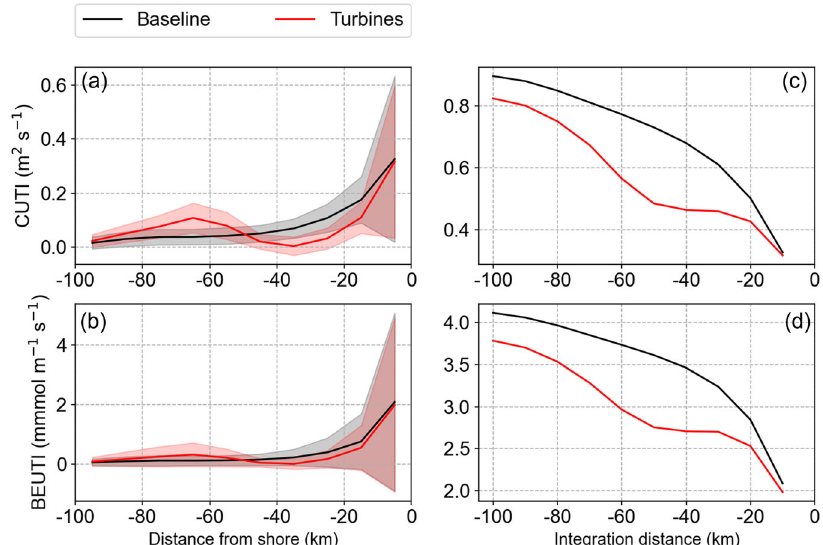
Fig. 7 Differences in upwelling metrics for volume transport and nutrient fl ux at 35 ∘ N. a Coastal Upwelling Transport Index (CUTI) and b Biologically Effective Upwelling Transport Index (BEUTI) as a function of distance from shore, calculated in 10 km bins, shown as bin-centered values. Shading indicates the interannual variability (i.e., standard deviation calculated across all years). Net upwelling at 35°N over increasingly wider swaths are shown in c CUTI, and, d BEUTI for various cross-shore integration distances, shown as values at the western edge of 10 km